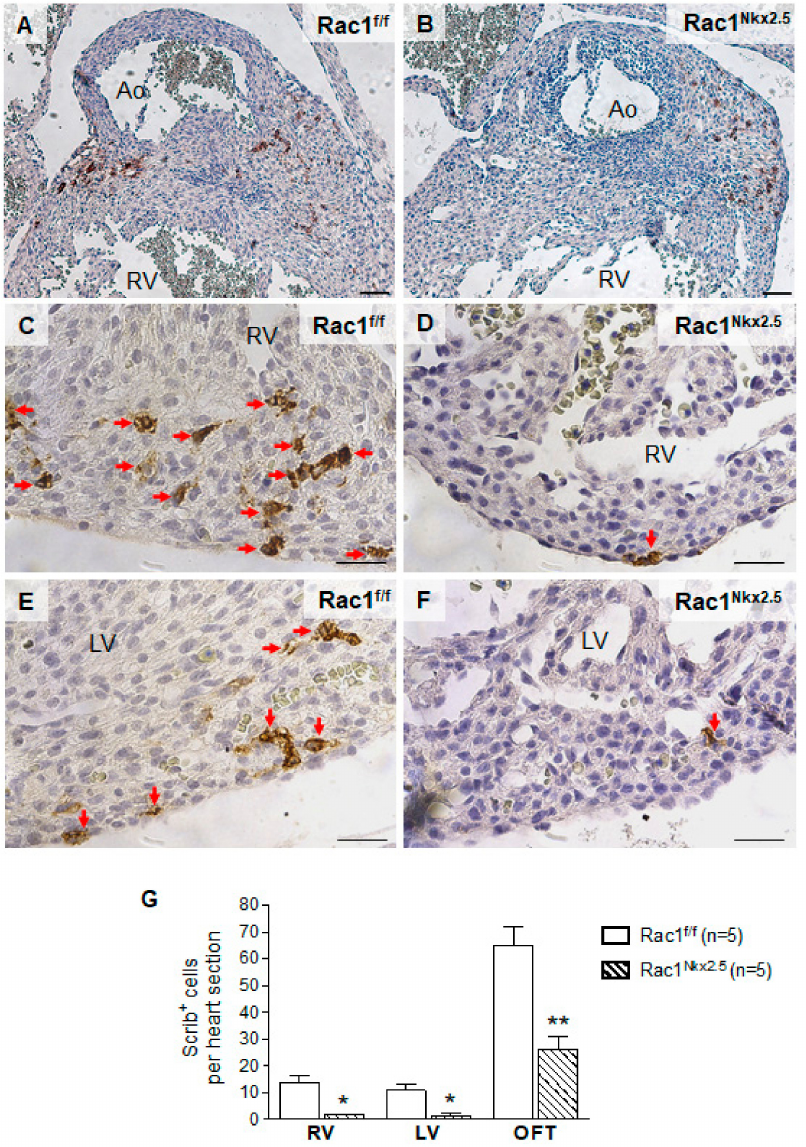
Figure 6. Loss of Scrib expression in Rac1 Nkx2.5 hearts. Scrib immunostaining was performed on E15.5 Rac1 Nkx2.5 and Rac1 f/f heart sections. The areas analyzed included the myocardium surrounding the aorta ( A , B ), RV ( C , D ) and the LV ( E , F ). Five sections per heart were used. The number of Scrib- expressing positive cells was significantly decreased in the myocardium surrounding the aorta (OFT), RV and LV of Rac1 Nkx2.5 hearts ( G ). * p < 0.05, ** p < 0.01 by Student’s t -test. Scale bars: 50 µ